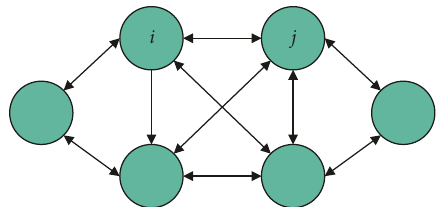
Figure 1: A graph representation of a